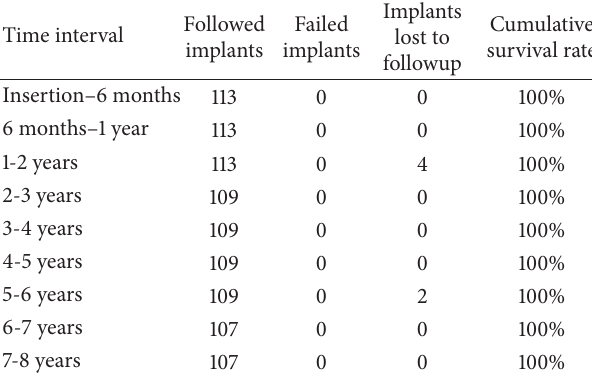
Table 2: Kaplan-Meier (life-table) analysis.